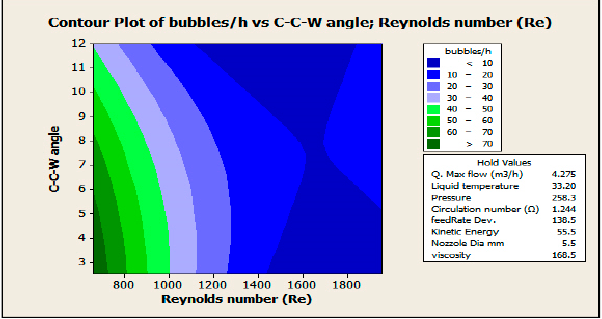
Figure 13. The contour plot of bubbles / h under Re and anti-clock wise angle direction.